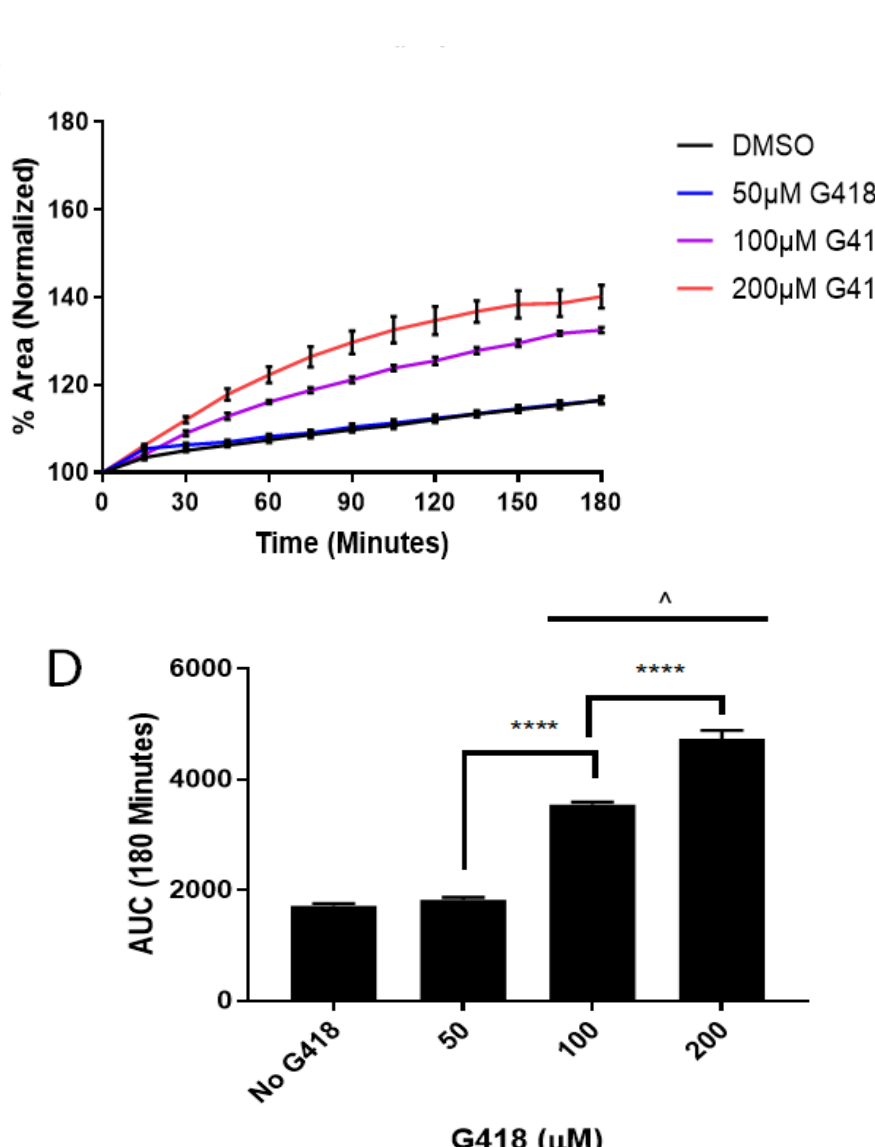
Figure 1. Readthrough with G418 in a cell based reporter system and G542X intestinal organoids ( A ). Firefly luciferase activity in 3T3 cells transfected with pFluc190UGA and treated with the indicated dose of G418. n = 3 wells per dose. * p < 0.0001 by one way ANOVA with post hoc Tukey test, ± SD. ( B ). Representative brightfield images of G542X intestinal organoids with indicated treatments at 0 and 180 minutes following stimulation with 10 µM forskolin. Scale bar is 100 µm. ( C ). FIS curves of intestinal organoids images every 15 min following forskolin stimulation. n = 3 wells per treatment group. ( D ). AUC measurements recorded from 1C. **** p < 0.0001, ^ p < 0.0001 vs. DMSO by one-way ANOVA with post hoc Tukey